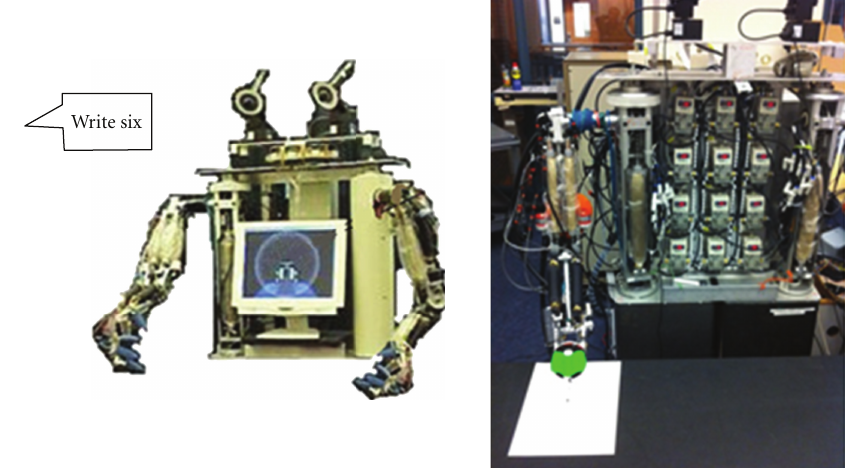
Figure 16: Command analysis and generation.